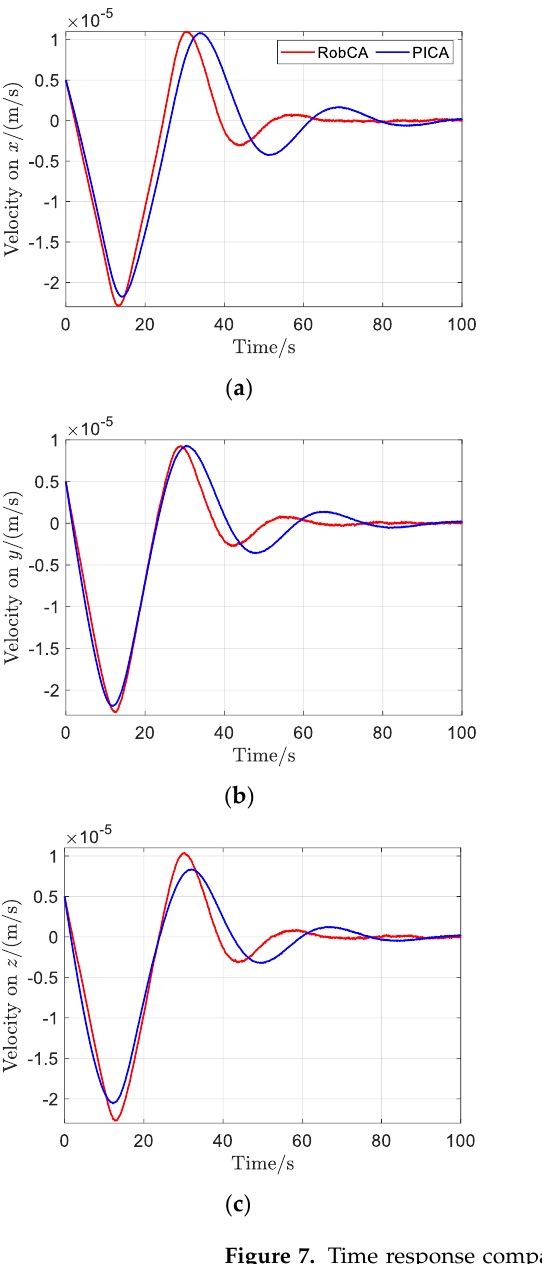
( b ) Figure 8. Trajectories of the position and attitude of the test mass with the RobCA method and the PICA method. ( a ) Position trajectories. ( b ) Attitude trajectories. The comparison of the nearest distance between the test mass and the electrode house along x , y , z axis with the RobCA method and the PICA method are presented in Figure 9. Figure 9 shows that the nearest distance between the test mass and the electrode house with the RobCA method is almost always larger than that of the PICA method. Accord- ingly, there is a greater safety margin in the test mass capture phase while the RobCA method is used as the control allocation method.